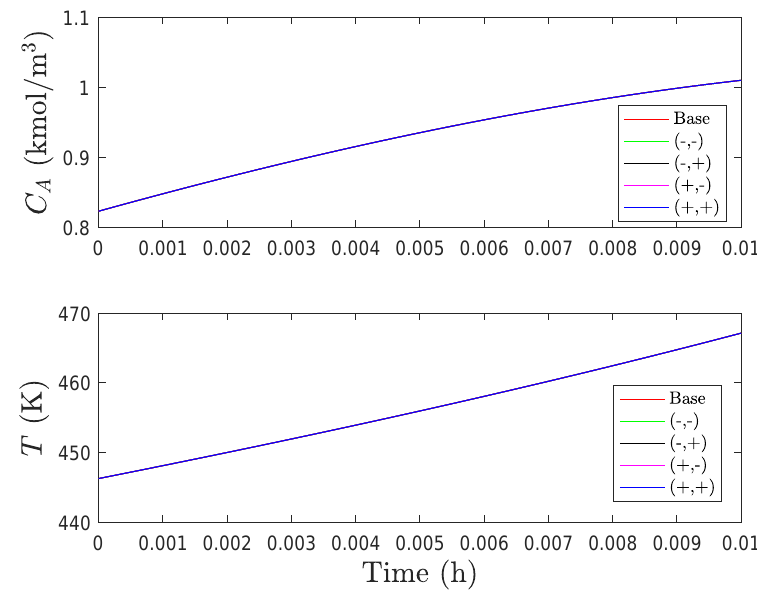
Figure 13. State trajectories for x ( t 0 ) = ( − 0.4 kmol/m 3 , 8 K ) and the four cyberattacks. Another initial condition, x ( t 0 ) = ( − 0.243 kmol/m 3 , 52.75 K ) , was also explored with the